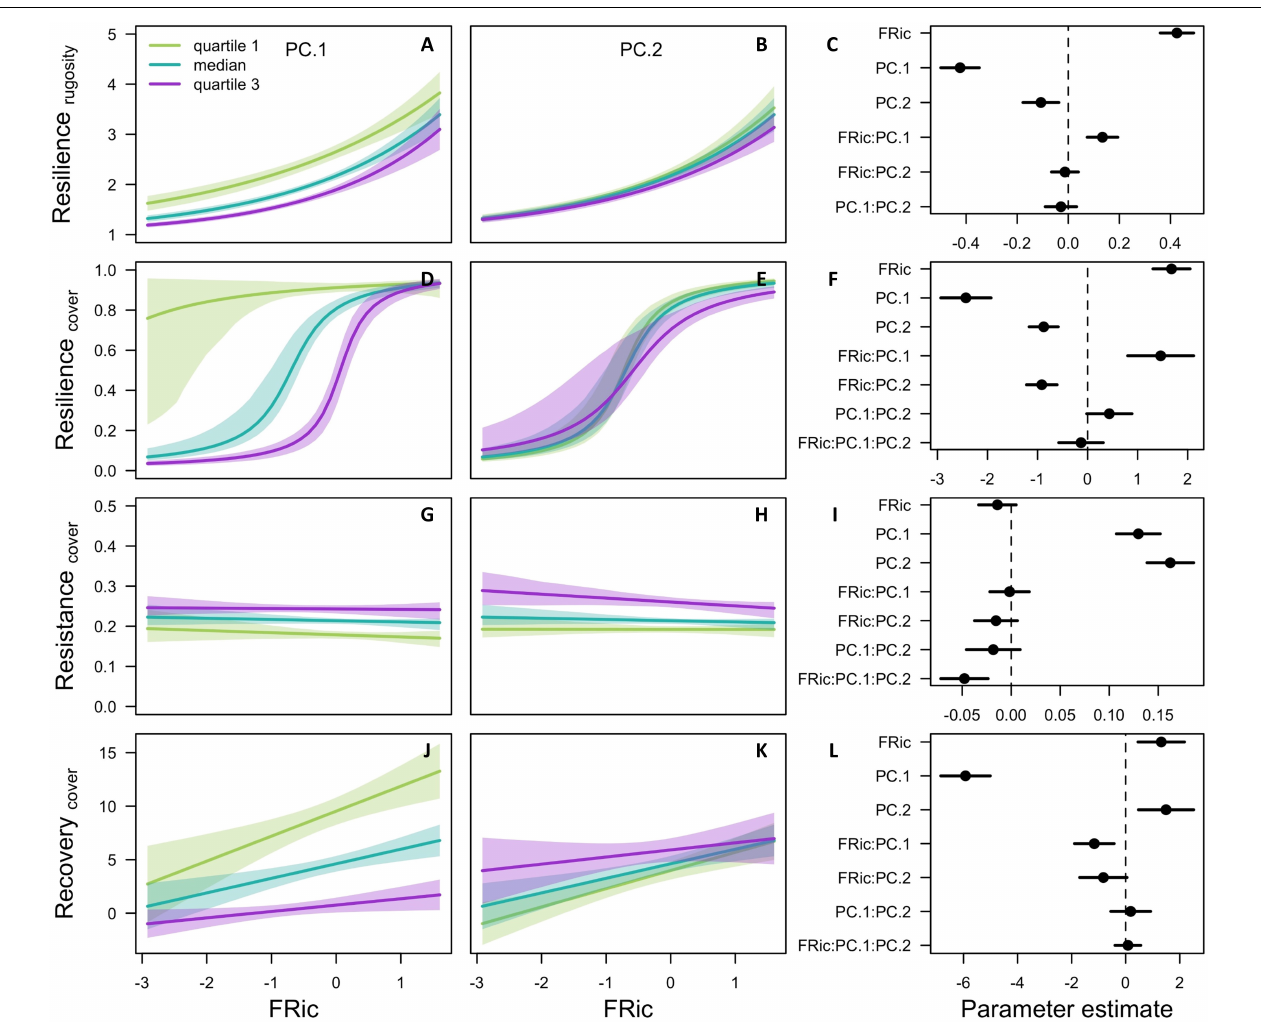
FIGURE 4 | Experimental results depicting interacting effects of FRic and CWM of traits on ecosystem resilience. Left and center panels show conditioning plots of FRic ( X -axes) versus one of four measures of resilience ( Y -axes), conditioned by CWMs of traits, specifically PC.1 (panels A,D,G,J ) and PC.2 ( B,E,H,K ). Green, turquoise, and purple lines represent model fits conditioned on the 1st, 2nd, and 3rd quartiles, respectively, of the conditioning variable (each n = 245). In all cases the secondary conditioning variable (either PC.1 or PC.2 ) was held at its median value. Right-hand panels show model-averaged parameter estimates and their 95% confidence intervals (C,F,I,L) .